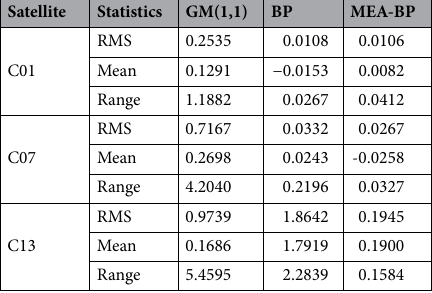
Table 2. Statistics of 3-h prediction results of three satellites (unit: ns).